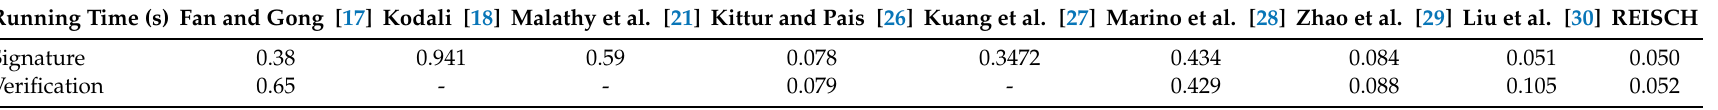
Table 6. Comparison of ECDSA’s